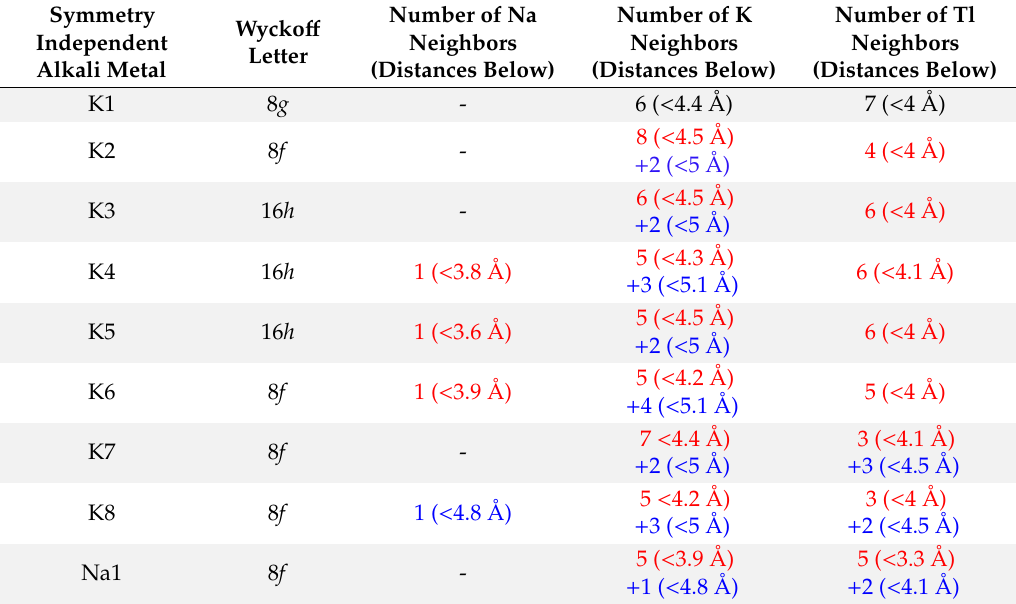
Table 13. Surrounding atoms of the symmetry inequivalent alkali metal positions in Na 2 K 21 Tl 19 (space group Cmcm ). The color-coding refers to the color of the contacts in Figure